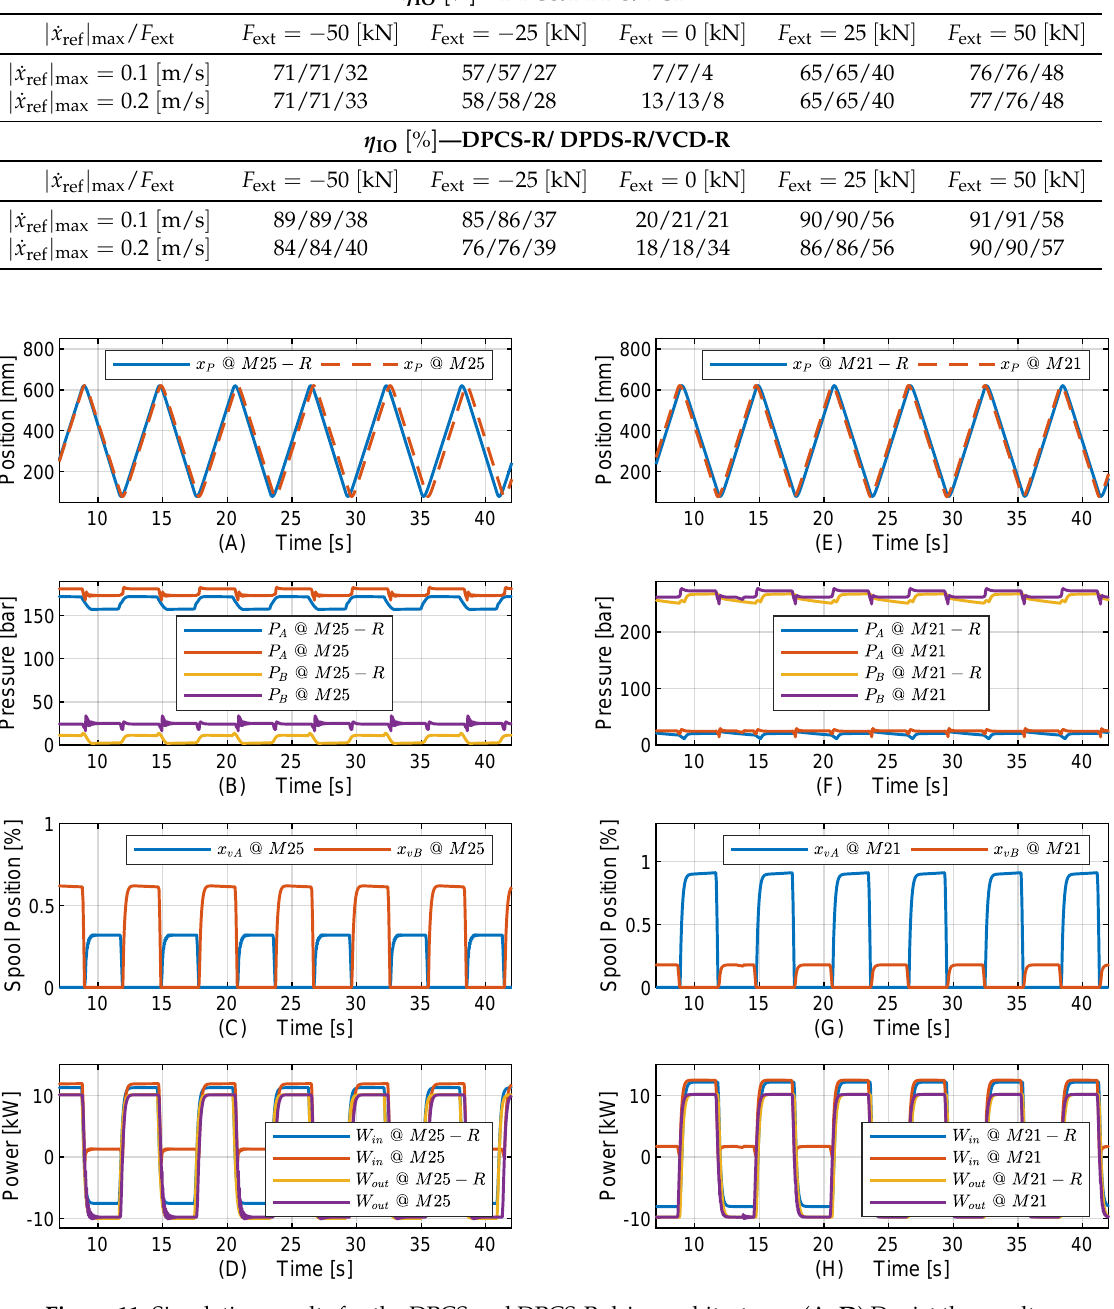
Figure 11. Simulation results for the DPCS and DPCS-R drive architectures. ( A – D ) Depict the results for M25, M25-R, and ( E – H ) depict the results for M21,